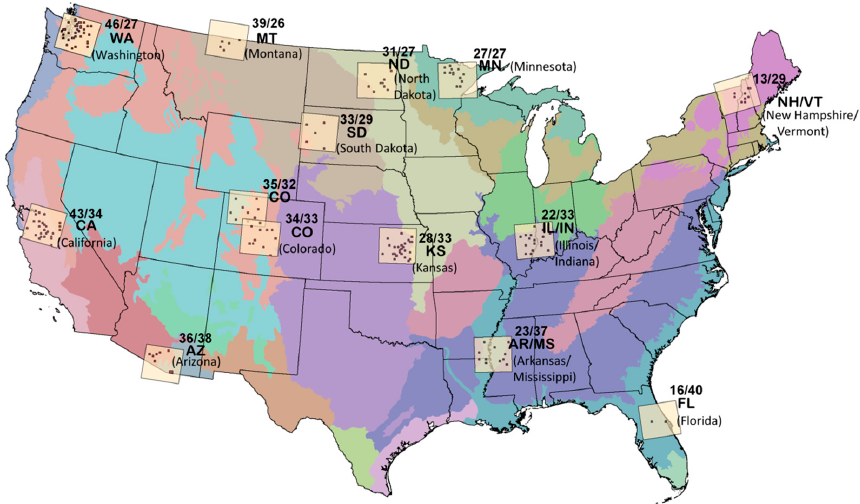
Figure 2. Land Cover (LC) Trends sample blocks (dot symbols) within the 14 path/row test locations.